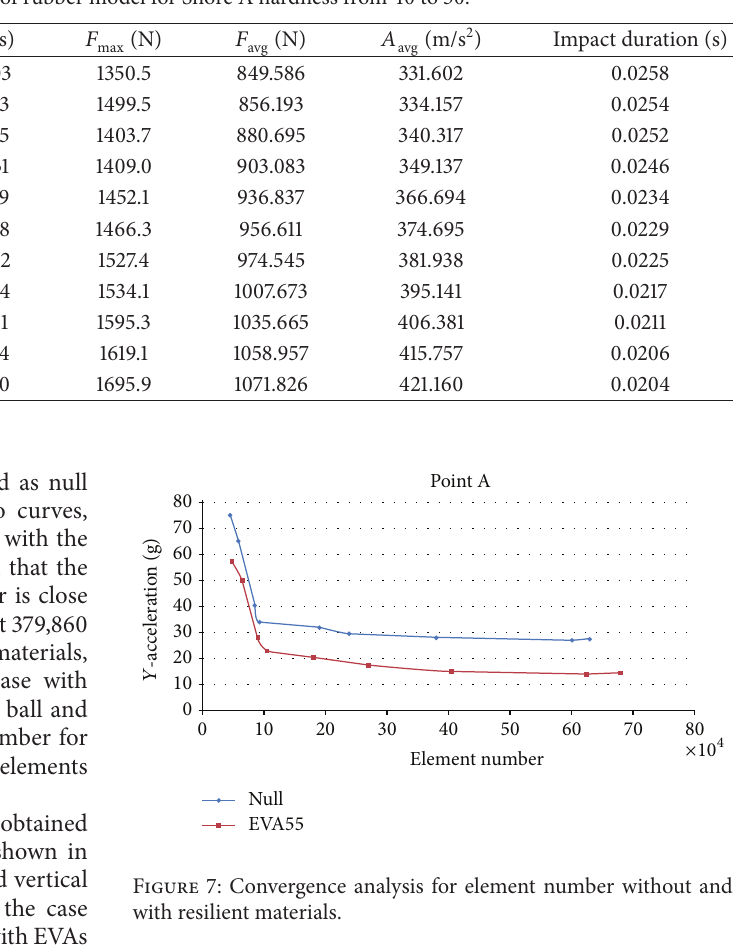
Table 4: Simulation results of rubber model for Shore A hardness from 40 to 50.